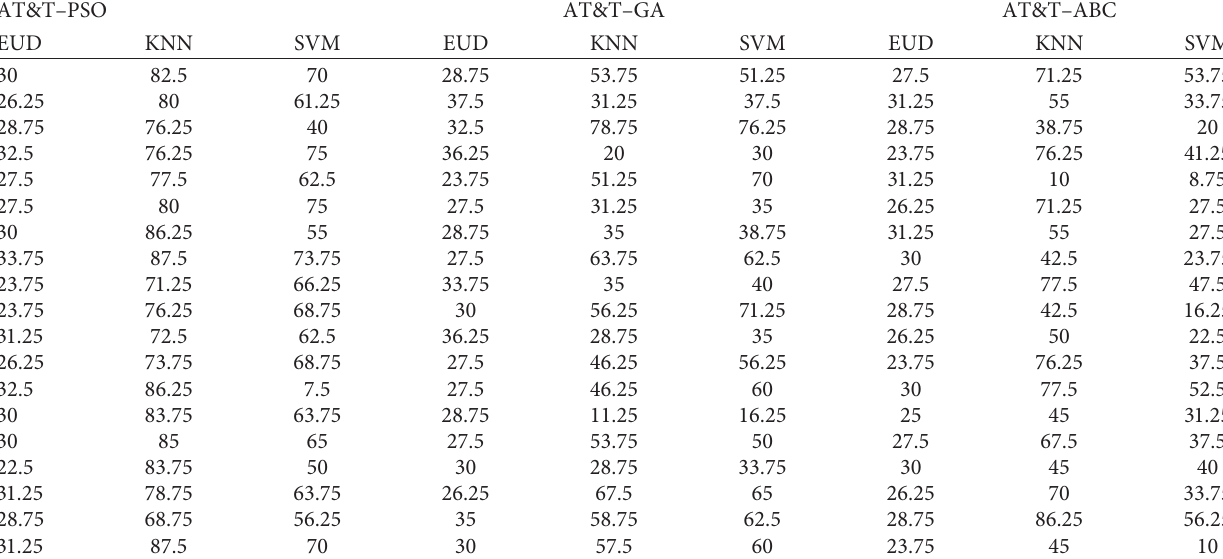
Table 9: AT&T experiment results for PSO, GA, and ABC using EUD, KNN, and SVM classifiers.